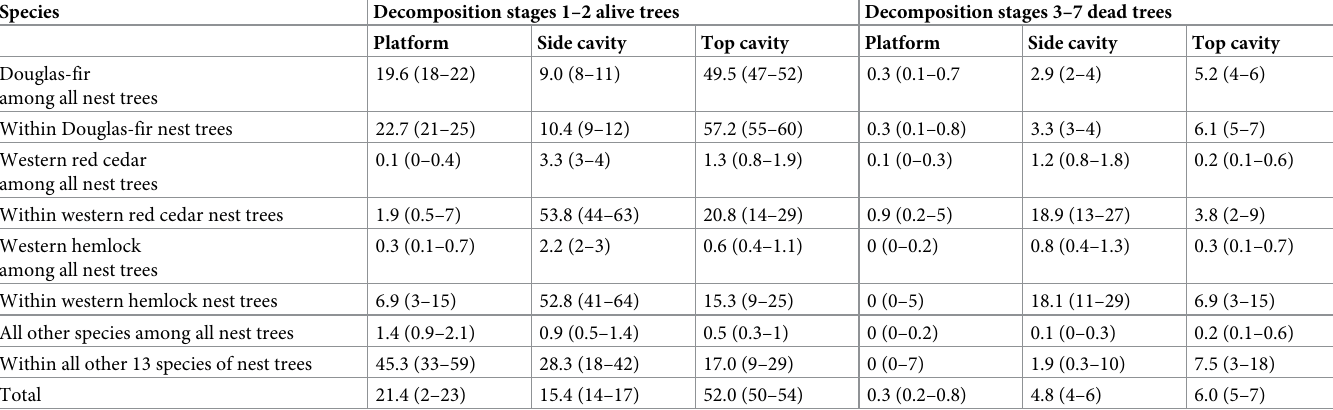
Table 2. Percentages of nest trees of northern spotted owl in Washington and Oregon, USA, subdivided by species, alive/dead decomposition stages and nest type. Parentheses show 95% confidence intervals ( n = 1717).